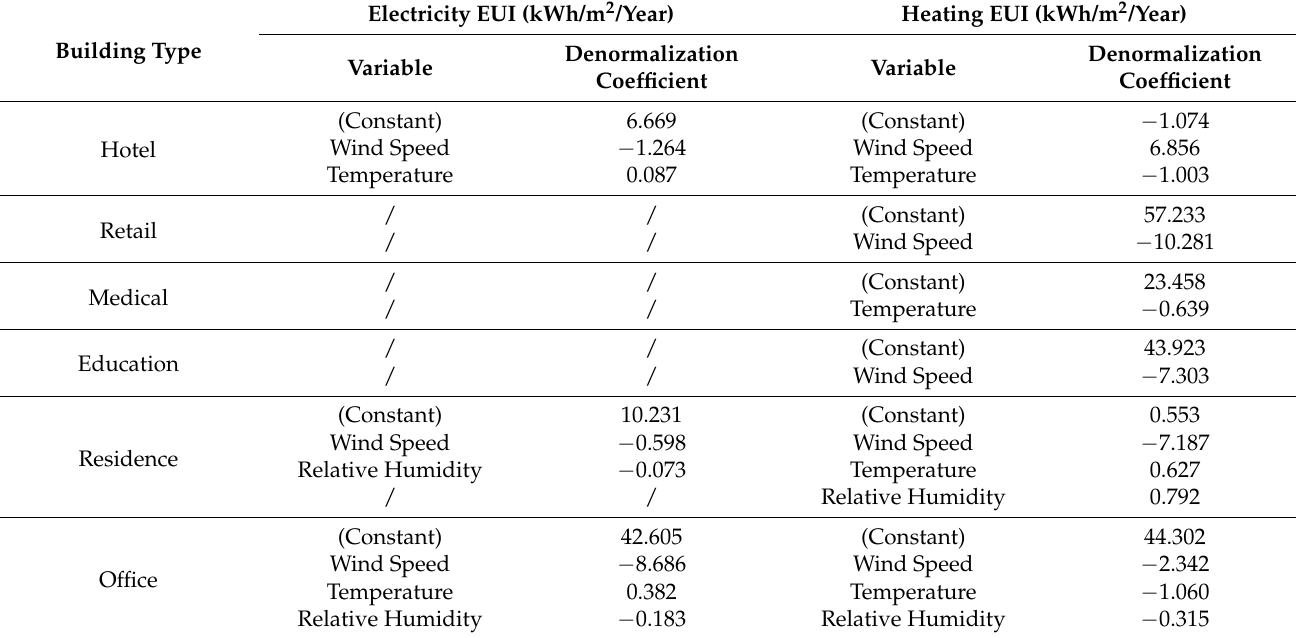
Table 3. Stepwise regression results of climate factors and building EUI.